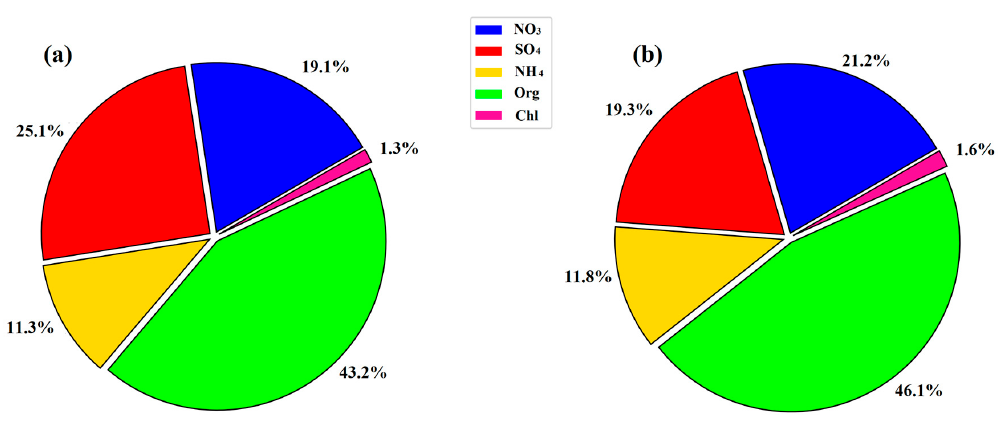
Figure 8. Aerosol mass fractions of fine-mode aerosol measured by the aerosol chemical speciation monitor (ACSM) for ( a ) Case I and ( b ) Case II. Blue, red, yellow, green, and pink represent NO 3 , SO 4 , NH 4 , organics, and chloride, respectively.